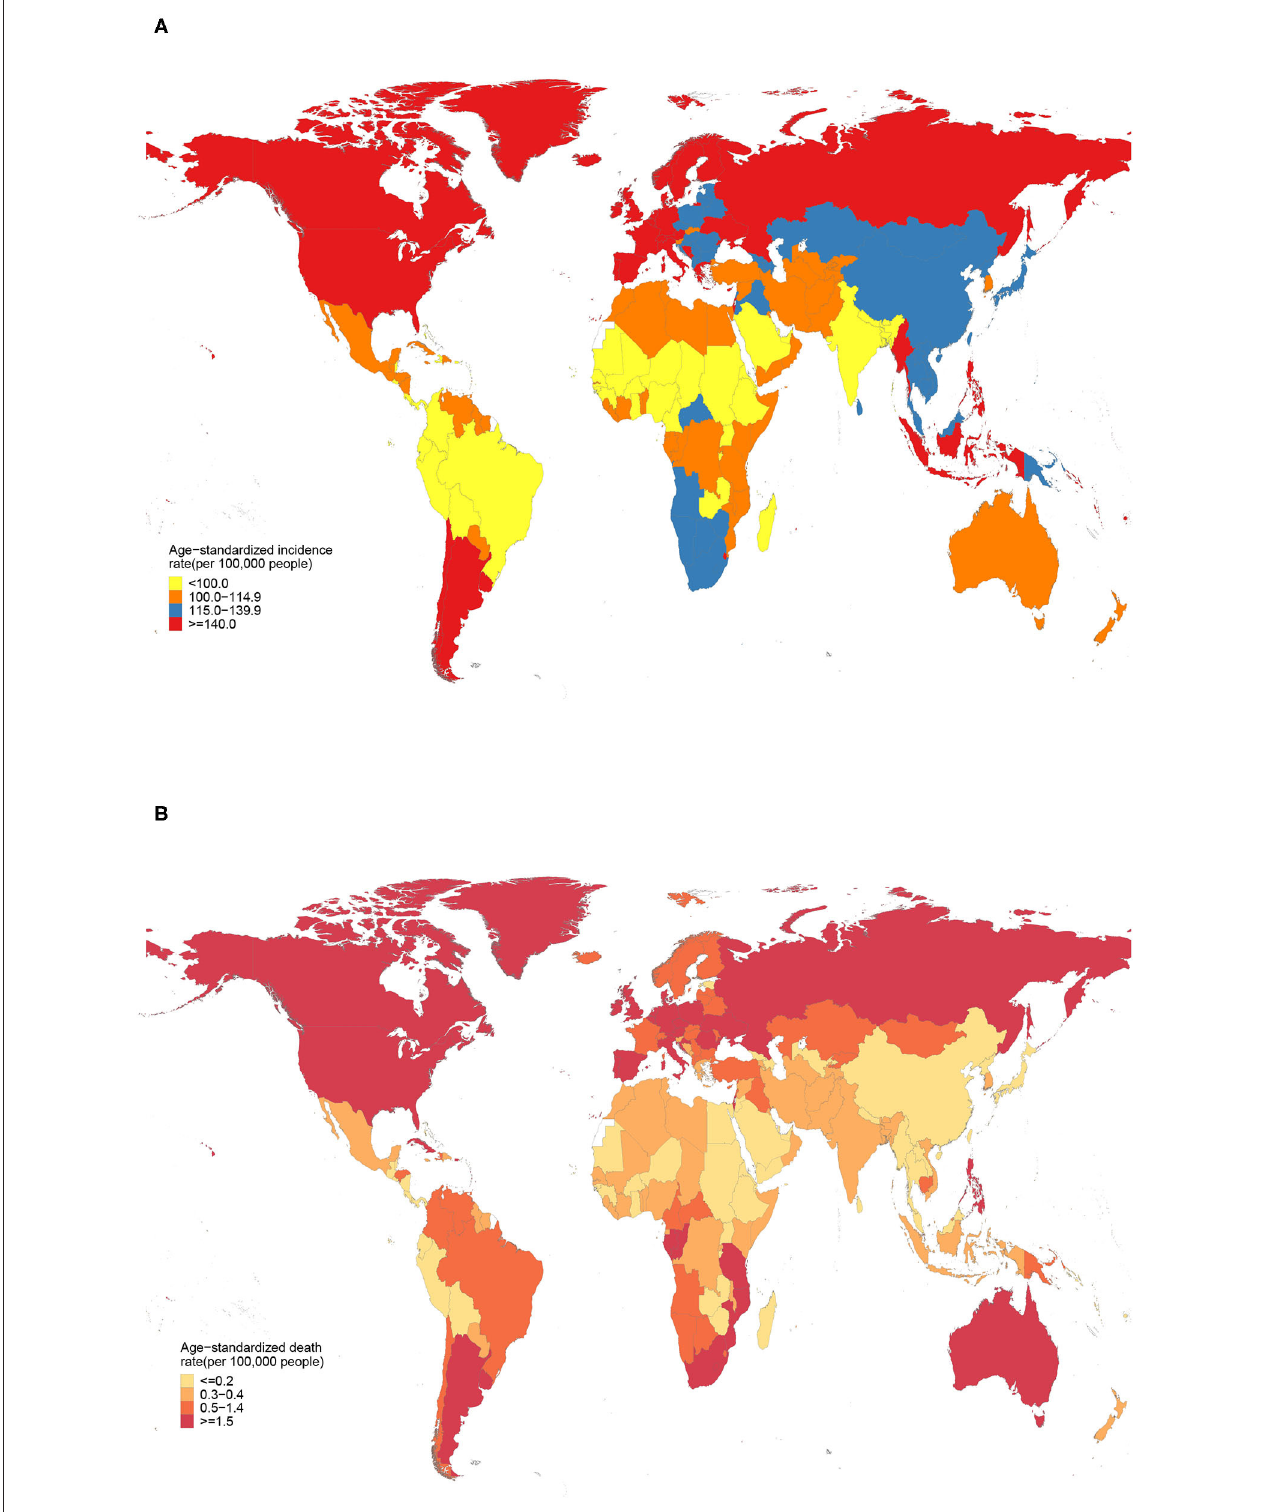
FIGURE 2 | Age-standardized incidence (A) and death (B) rates of peripheral artery disease across 204 countries and territories in 2019.